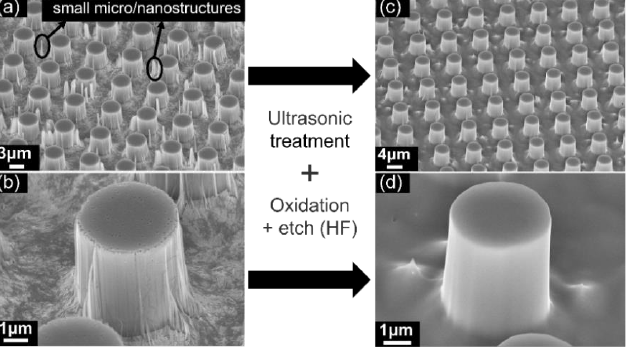
Figure 4. SEM pictures of micropillars produced by metal-assisted chemical etching. ( a ) There are both micropillars and some redundant small micro-/nanostructures on the surface (ρ = 0.6, [H 2 O 2 ] = 2.26 M, t = 28 min), ( c ) small micro-/nanostructures were almost removed by the process of ultrasonic treatment, surface oxidation and dissolving in HF. The rough surface of micropillars ( b ) became smooth ( d ) by surface oxidation and dissolving in the HF process.